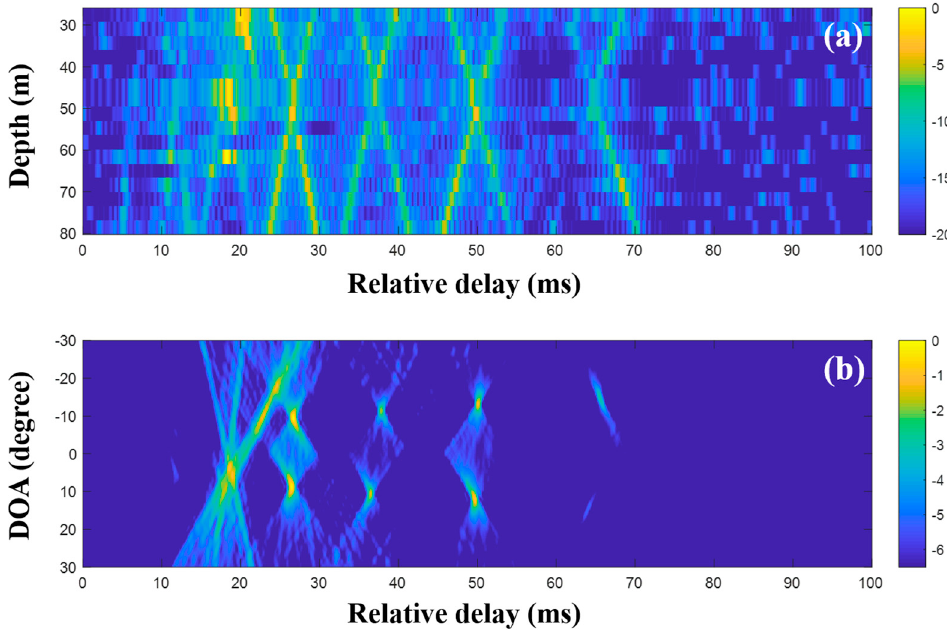
Figure 6. Direction-of-arrival (DOA) estimation using compressive sensing (CS) with multiple measurements. The signal-to-noise ratio (SNR) is − 9.8 dB: ( a ) arrival structures via sequential CS usage with the signals at the vertical line array (VLA), and ( b ) DOAs using delay-and-sum beamforming with the arrival structures.